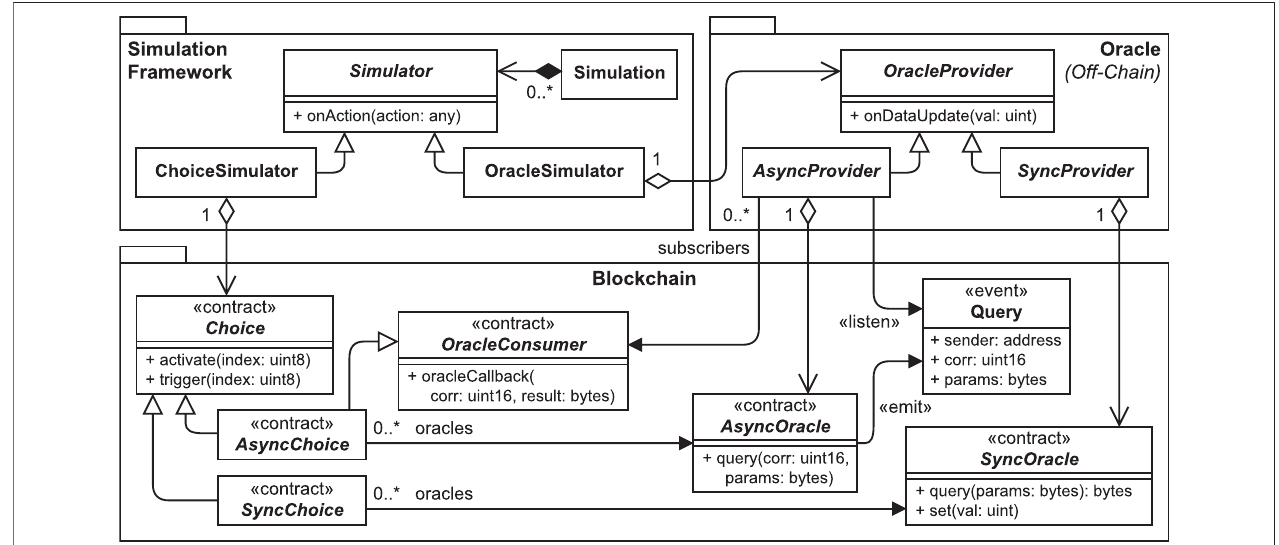
FIGURE 6 | Overall design of the prototype as a Uni fi ed Modeling Language (UML) class